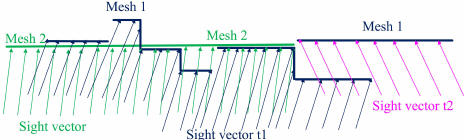
Figure 7. A sensor mesh from the left laser sensor. There are holes in specular reflection areas(glass and metal).